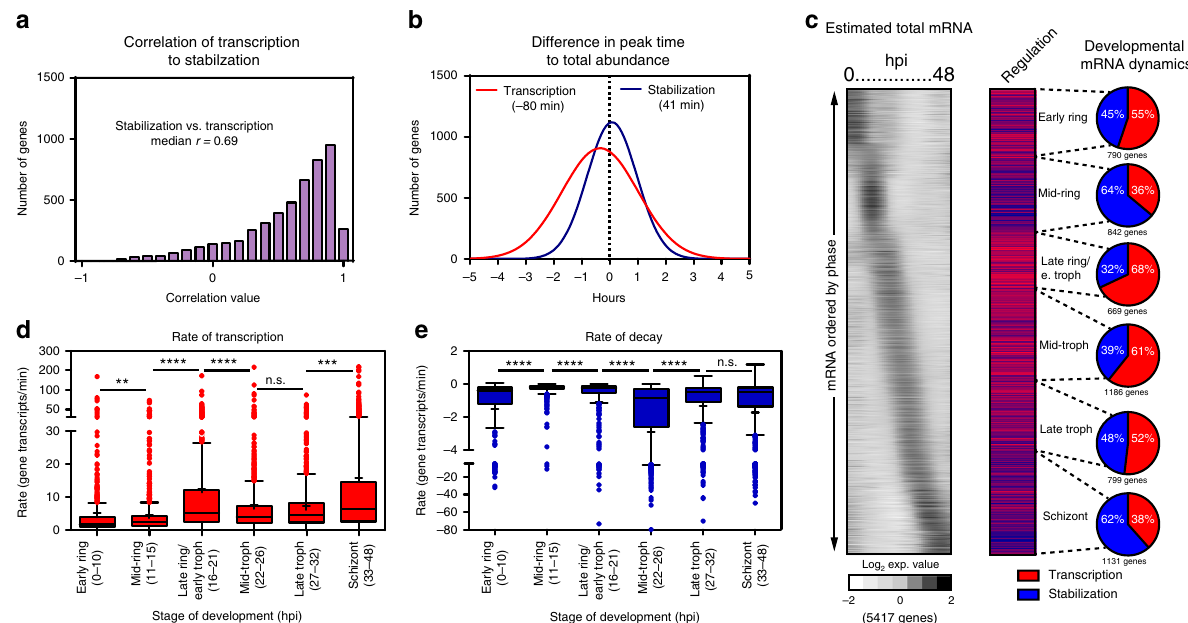
Fig. 2 Temporal mRNA dynamics during the IDC of P. falciparum . a The correlation values of gene transcription and stabilization are summarized in a histogram plot with a median value of r = 0.69. b The difference in the peak time of nascent gene transcription (red line) and stabilization (blue line) to the peak time of mRNA abundance for each gene was calculated and displayed as a histogram. c The dominant mode of regulation was determined for each gene by calculating the correlation of the modeled transcription or stabilization ( r ≥ 0.5) to the estimated total mRNA abundance pro fi le for each gene throughout the IDC and are displayed in order of the peak timing of abundance (hpi). The percentage of genes regulated by either transcription (red) or stabilization (blue) is summarized for major morphological stage transitions: early ring (790 genes), mid-ring (842 genes), late-ring/early-trophozoite (669), mid-trophozoite (1186 genes), late-trophozoite (799), and schizont stage (11,310). Box-whisker plot of d transcription and e decay rates calculated for early ring, mid-ring, late ring/early trophozoite, mid-trophozoite, late trophozoite, and schizont stages of parasite development (Supplementary Data 2). The mean rate ( + ) and Tukey ’ s distribution are displayed for each stage of development. Adjusted p values from one-way ANOVA comparisons are noted (** p = 0.006; *** p = 0.0002, **** p < 0.0001). Rates that are outliers are displayed as individual